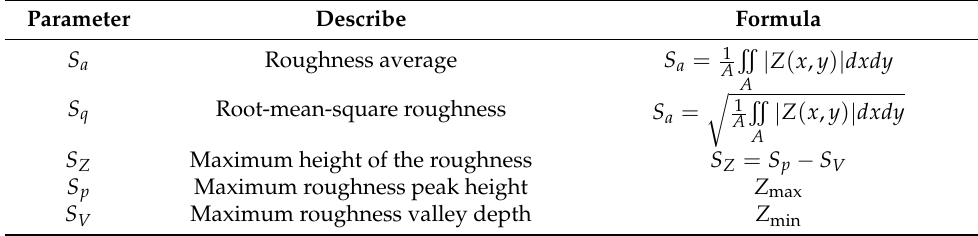
Table 5. Three-dimensional (3D) roughness parameters used in this study.